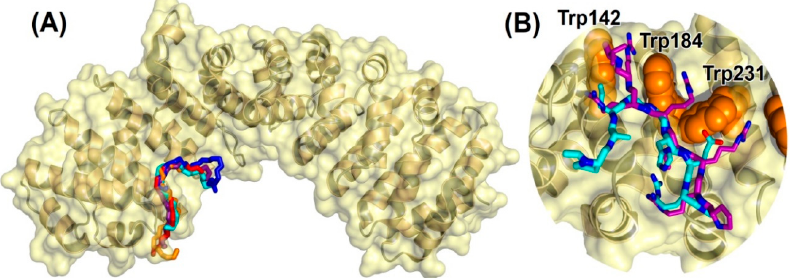
Figure 6. Predicted docking poses for NUPR1L peptide on importin. ( A ) Bound conformation of the capped fragment PAPGGHER: backbone (–N–C α –C– atoms) representation of the best five docking poses on ∆ Imp α 3. ( B ) Most favorable binding pose of the same fragment (cyan), compared with the crystallographic conformation [37] of the NLS of the Epstein–Barr virus EBNA-LP protein (purple). For clarity, H atoms and backbone O atoms are omitted. The tryptophan residues (orange) in the major NLS-binding site of importin are labeled. All images were created with PyMol [38].